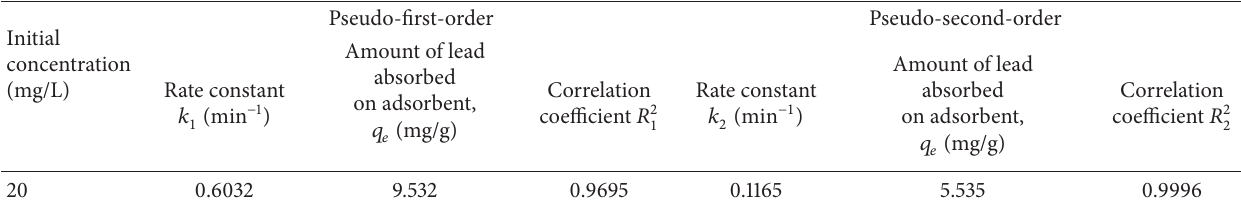
Table 4: Kinetic constants for lead onto Ficus benghalensis L.